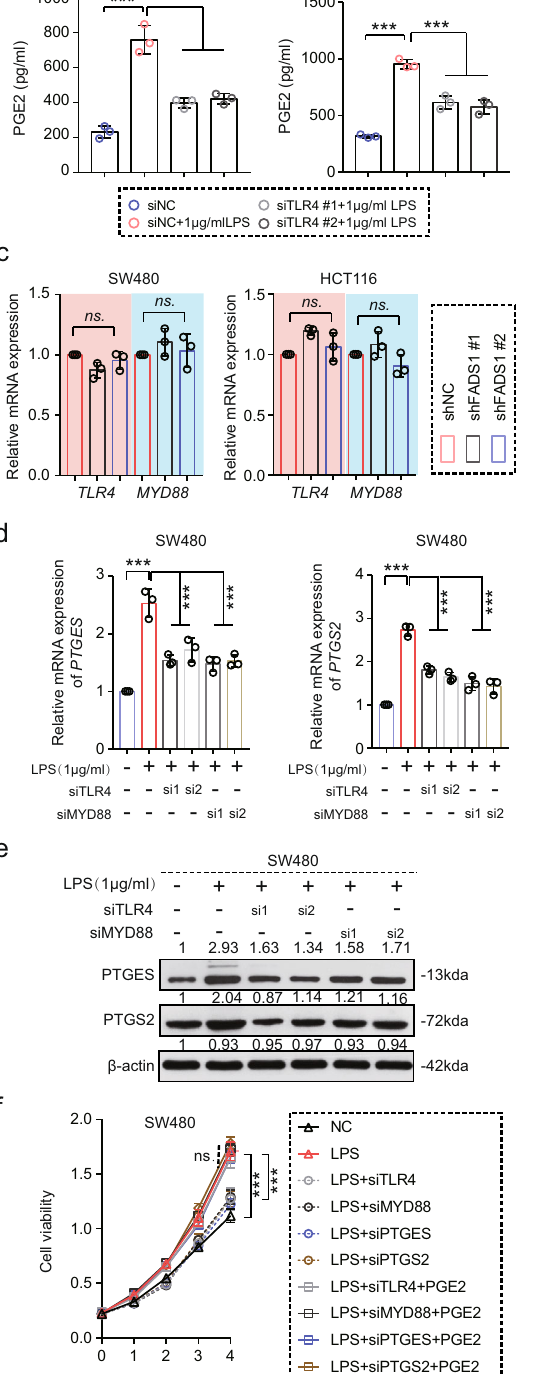
Fig. 6 | The TLR4/MYD88 pathway is involved in the gut microbe-mediated PGE2 production. a PGE2 levels in SW480 and HCT116 cells transfected with si TLR4 , activated by 1 μ g/ml of LPS ( n =3 per group, means ± s.d.; two-tailed unpaired t test, n =3biologicalreplicates).*** p <0.001. b PGE2levelinSW480and HCT116cellstransfectedwithsi MYD88 ,activatedby1 μ g/mlofLPS( n =3pergroup, means ± s.d.; two-tailed unpaired t test, n=3 biological replicates). *** p <0.001. c TLR4 and MYD88 expression in SW480 and HCT116 cells transfected with sh FADS1 or shNC. TLR4 and MYD88 expression were detected by q-PCR and wes- tern blot. The grayscale values of the WB bands are quantitatively represented (n=3biologicalreplicates). d ThemRNAexpressionof PTGES and PTGS2 inSW480